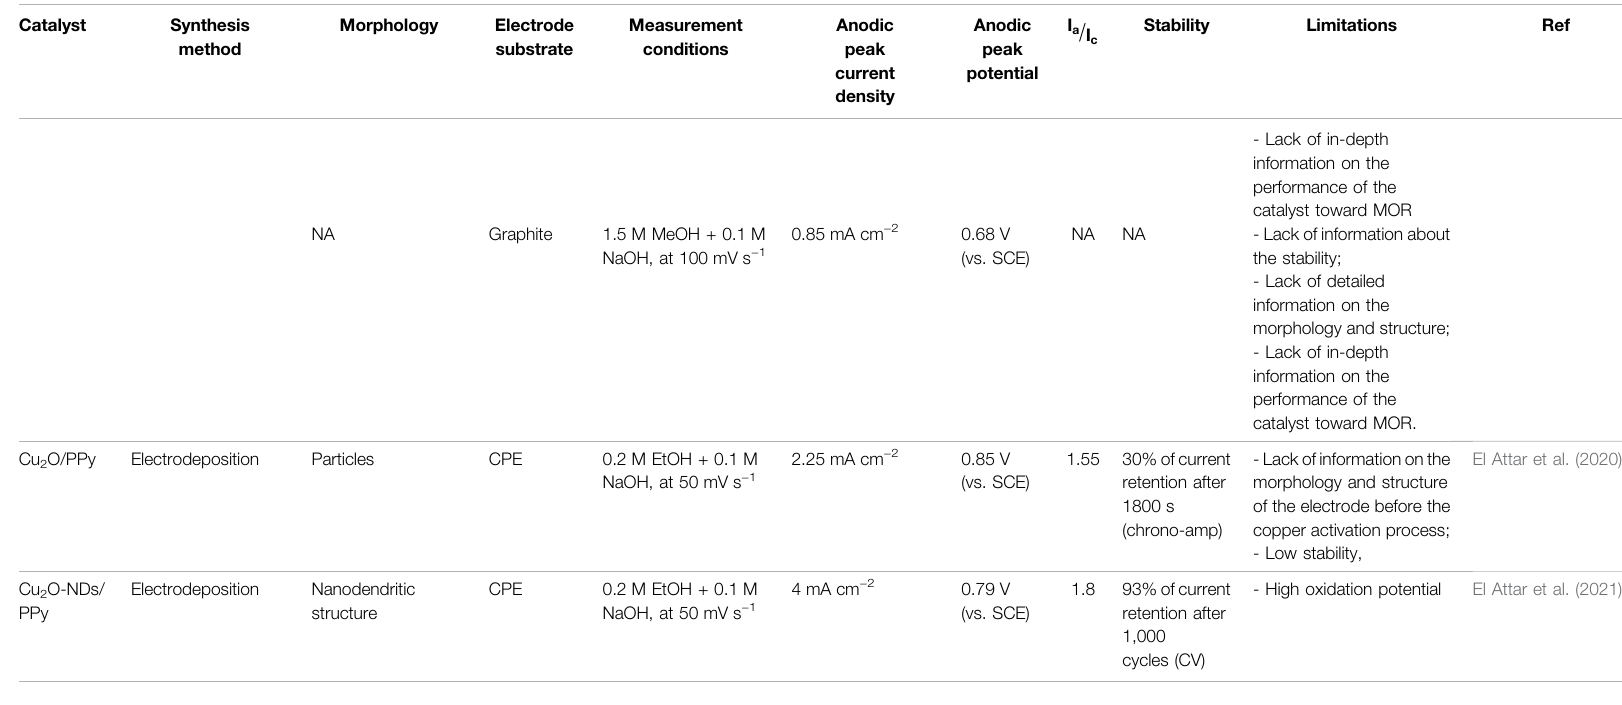
TABLE 2 | ( Continued ) Electrochemical properties and electrocatalytic performances of monometallic-based conducting polymers catalyst applied for alcohol